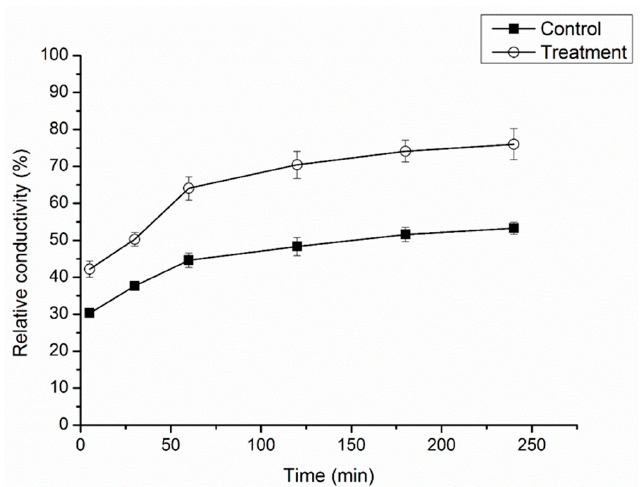
Figure 1. Effect of cuminic acid on mycelia morphology of FON. ( d – f ) Untreated plates; ( a – c ) Plates treated with cuminic acid at EC 50 value (22.53 μ g/mL). Values are means and standard errors.